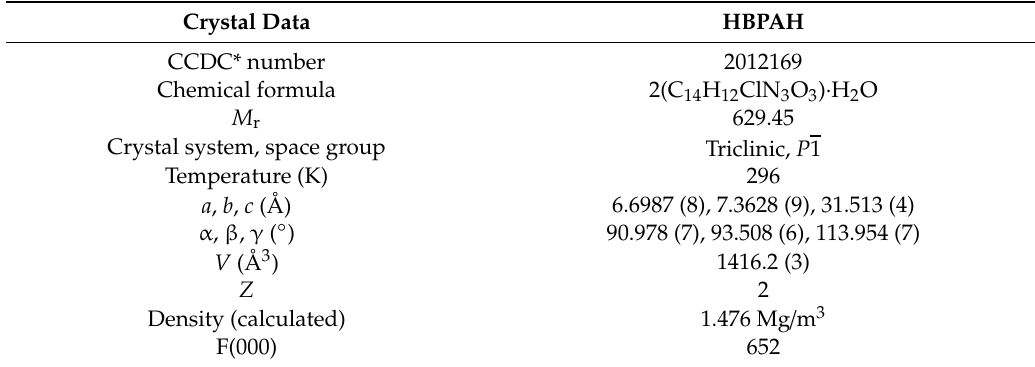
Table1. Experimentaldetailsofthecompound(E)-2-((6-chloropyridin-2-yl)oxy)-N (cid:48) -(2-hydroxybenzylidene) Experimental details of the compound (E)-2-((6-chloropyridin-2-yl)oxy)-N'-(2- acetohydrazide hydroxybenzylidene) acetohydrazide (HBPAH) .